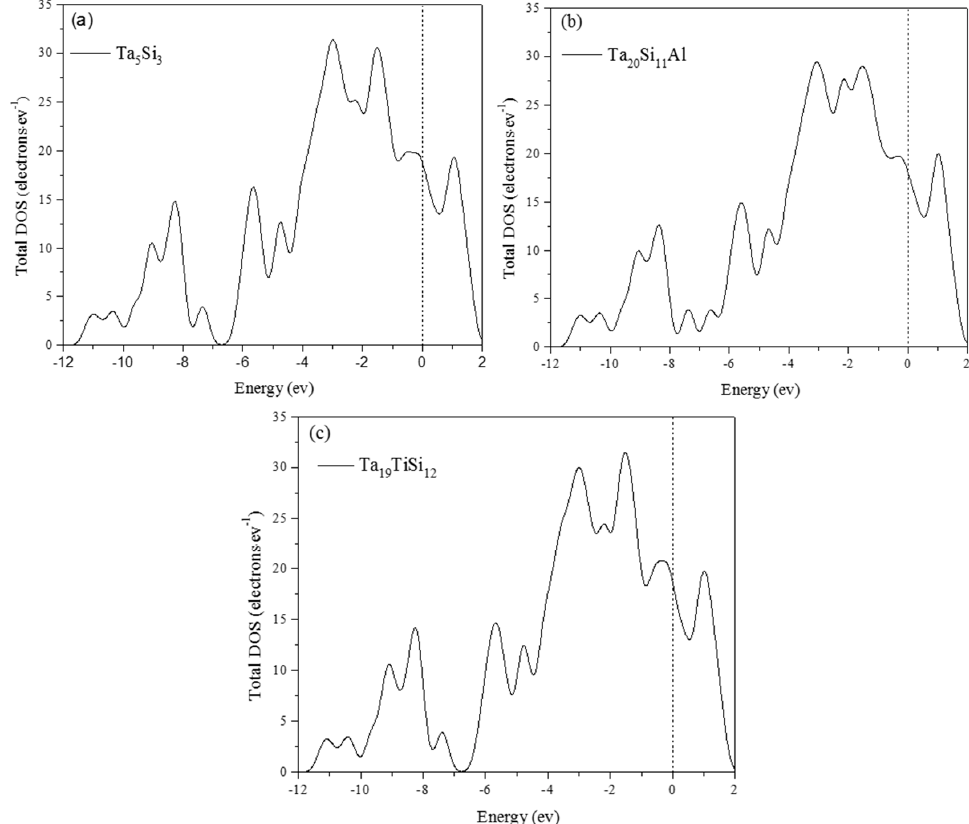
Figure 6. Calculated total density of states (DOS) for ( a ) Ta 20 Si 12 ; ( b ) Ta 20 Si 11 Al 8h and ( c ) Ta 19 Si 12 Ti 4b .